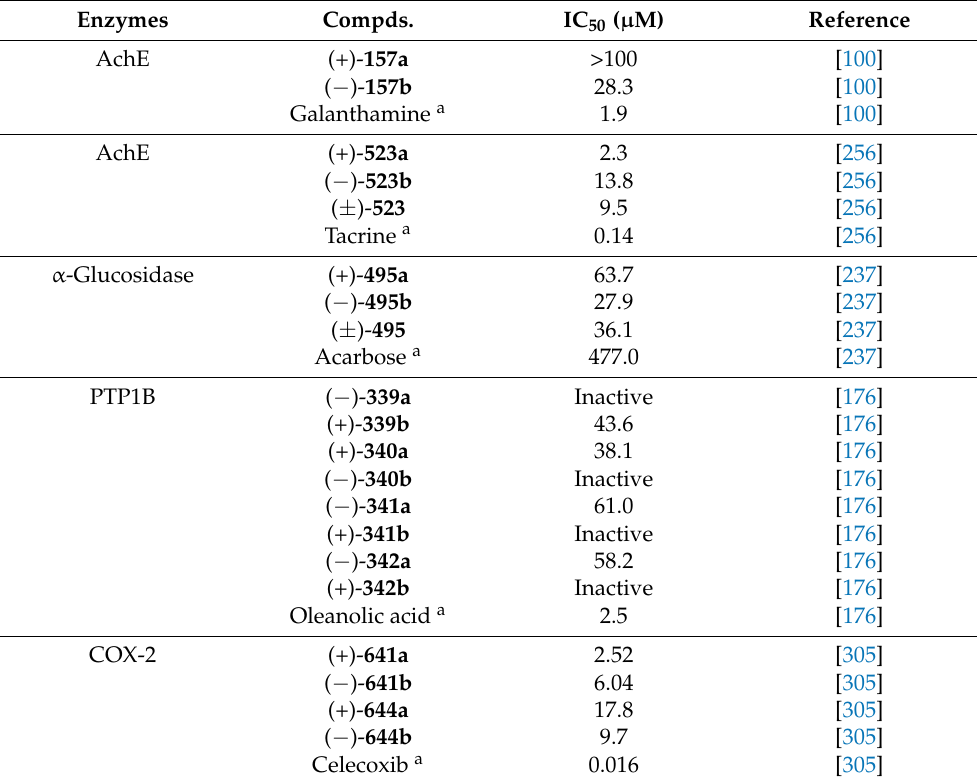
Table 9. Enzyme inhibitory activities of